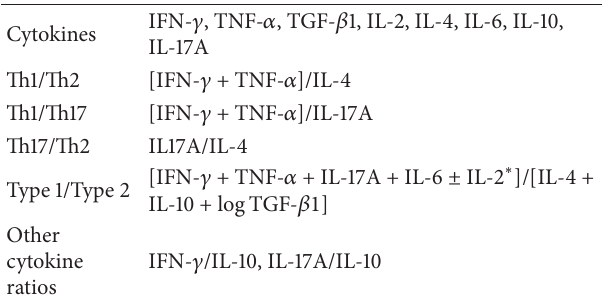
Table 1: Cytokines and cytokine ratios measured in the serum and CSF of RRMS patients.